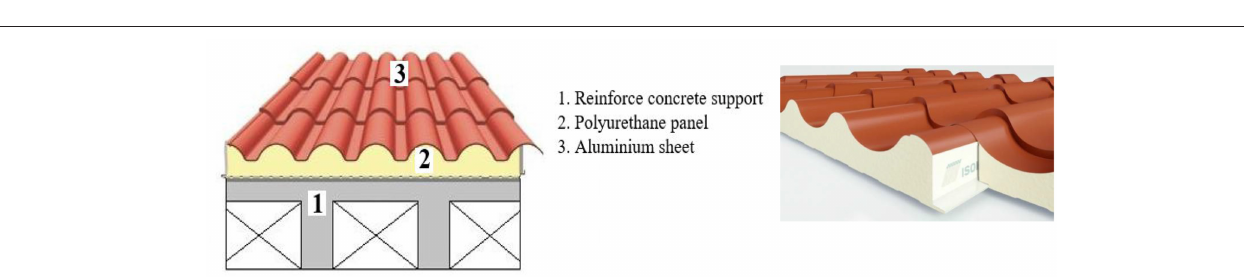
FIGURE 10 | Roof energetic upgrading through a new insulation